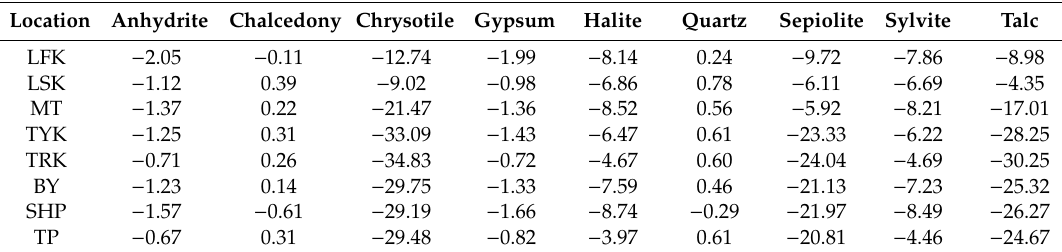
Figure 6. Na-K-Mg diagram for the Tatun geothermal field. Table 4. Mineral saturation index of the Tatun geothermal Table 4. Mineral saturation index of the Tatun geothermal field.